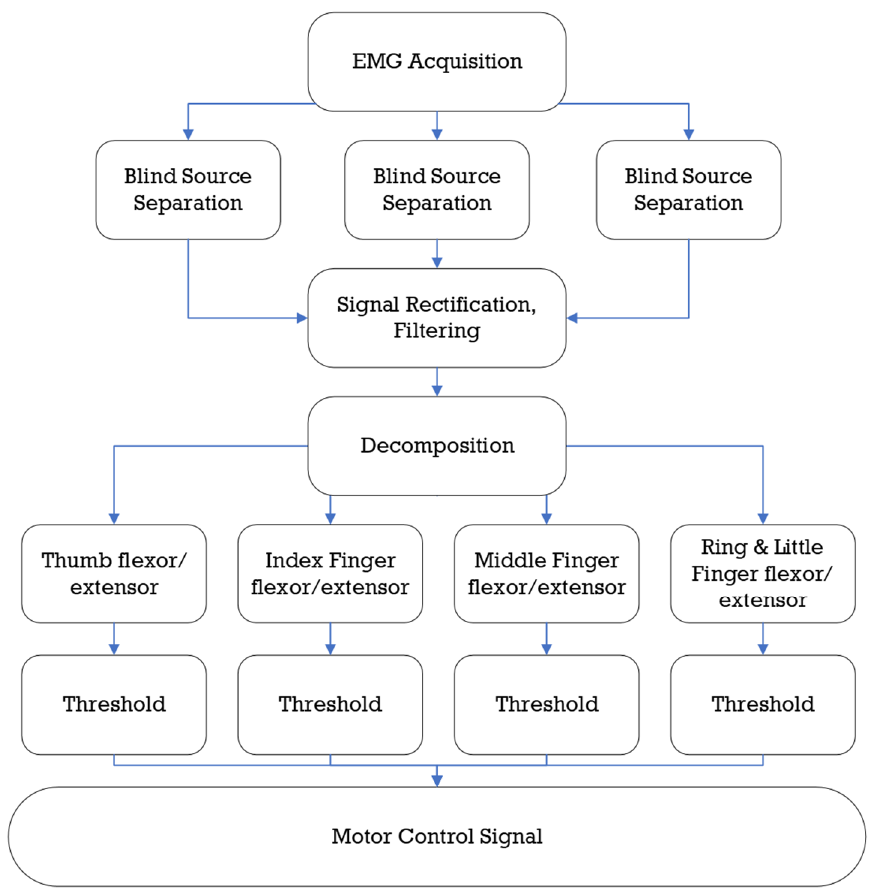
Figure 14. Wege’s EMG control algorithm recreated; The device begins by reading the sensed values from three sources before filtering and deciphering the data to control the actuation [70]. The human hand uses several groups of muscles to extend and flex the